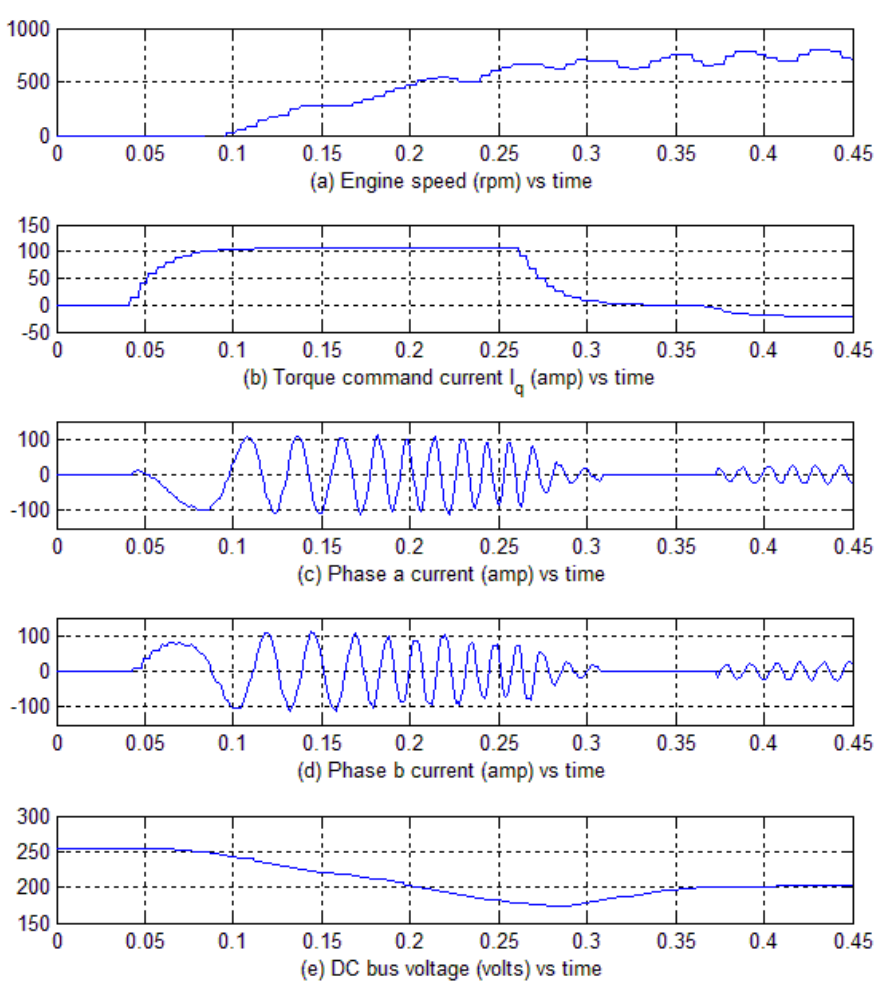
Figure 10. In vehicle testing result for the ISA with the proposed gain scheduler. ( a ) Engine speed in rpm; ( b ) Torque command current; ( c ) Motor phase a current; ( d ) Motor phase b current; ( e ) DC bus